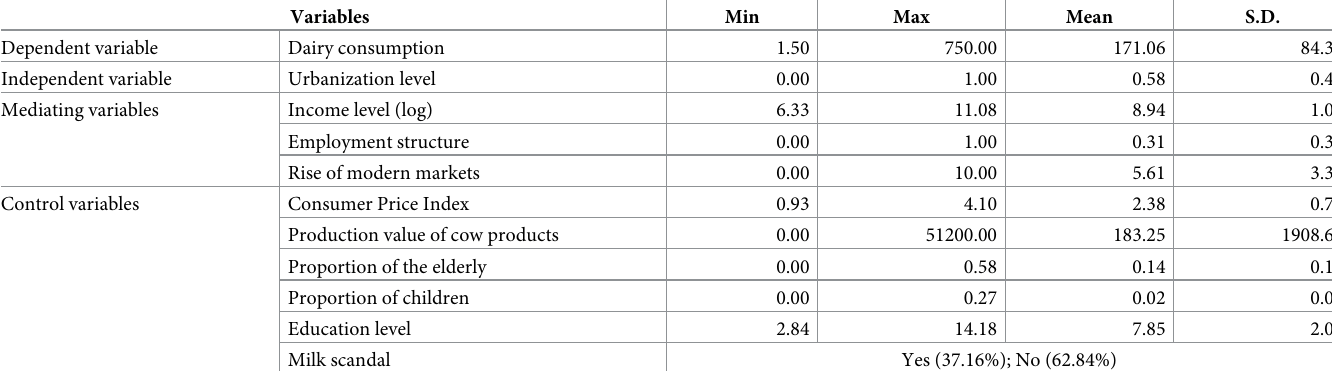
Table 2. Descriptive statistics